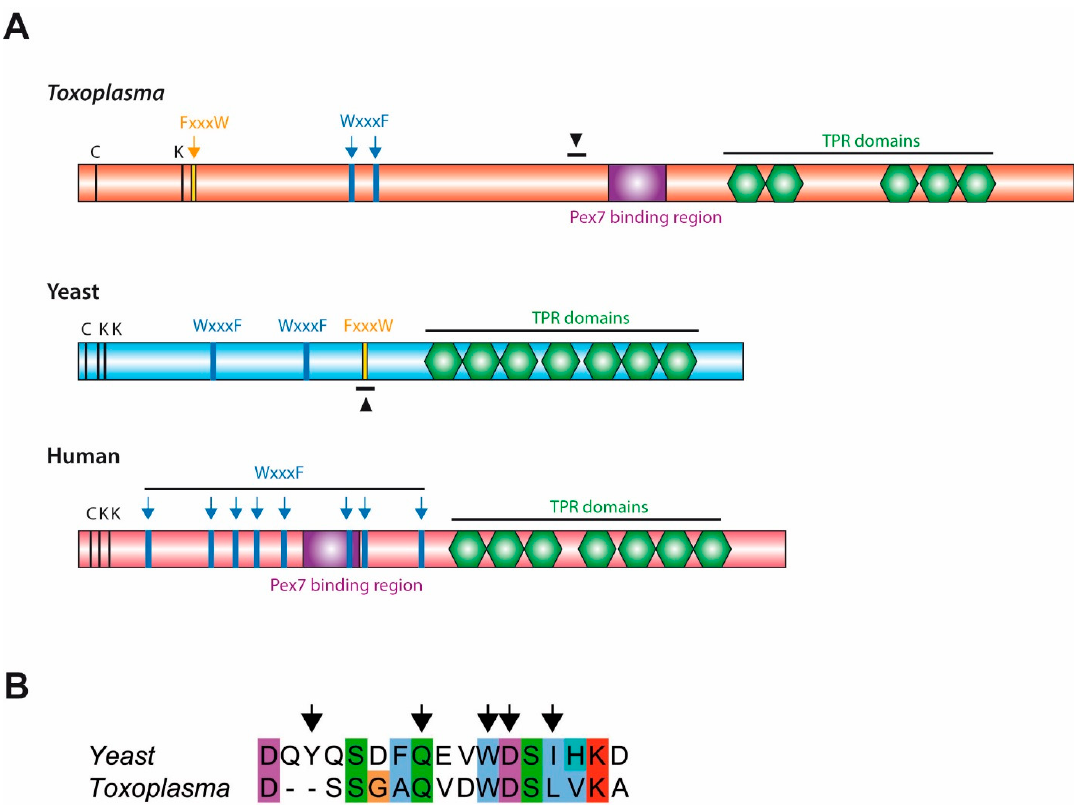
Figure 1. ( A ) Toxoplasma Peroxin 5 (Pex5) contains structural characteristics conserved in yeast and human Pex5. Bioinformatic comparison of the Toxoplasma Pex5 protein sequence with yeast and human counterparts indicated the presence of critical cysteine and lysine residues (C, K), pentapeptide motifs (WxxxF/FxxxW) and structural domains (Pex7-binding region and TetratricoPeptide Repeat [TPR] domains which bind peroxisomal-targeting signal 1 [PTS1] ligands) characteristic of Pex5. Additionally, a region homologous to the Fox1 binding site in yeast Pex5 is also found in Toxoplasma Pex5; indicated by black arrowheads. ( B ) Sequence alignment of the Fox1 binding site in yeast Pex5 ( Sc Pex5 251-267 ) with Toxoplasma Pex5 ( Tg Pex5 442-456 ), arrows indicate positions in Sc Pex5 critical for Fox1 binding